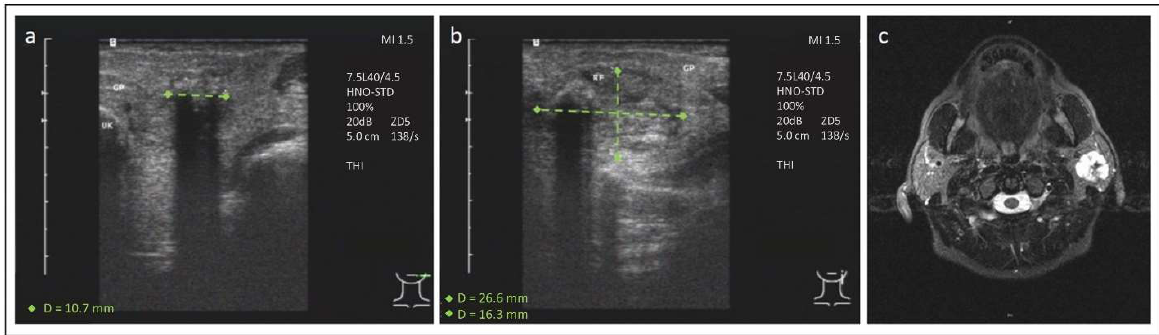
Figure 3. Ultrasound and MRI findings of a 47-year-old female patient with recurrent swelling and pain of the left parotid gland. ( a ) Initial ultrasound examination revealing an echogenic reflex with dorsal sound cancelling in the central part of the left parotid gland. UK = mandibule, GP = left parotid gland. (Siemens Medical Solutions, Acuson S3000). ( b ) A second ultrasound examination showing the echogenic reflex within a slightly delimitable tumor of 27 to 16 mm of the left parotid gland. RF = tumor, GP = left parotid gland (Siemens Medical Solutions, Acuson Sequoia). ( c ) MRI examination with T2 stir transversal sequence showing an inhomogeneous tumor with high signal intensity.